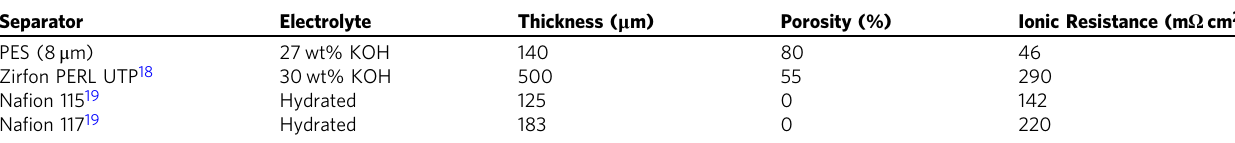
Table 1 Ionic resistance of separators at room temperature.